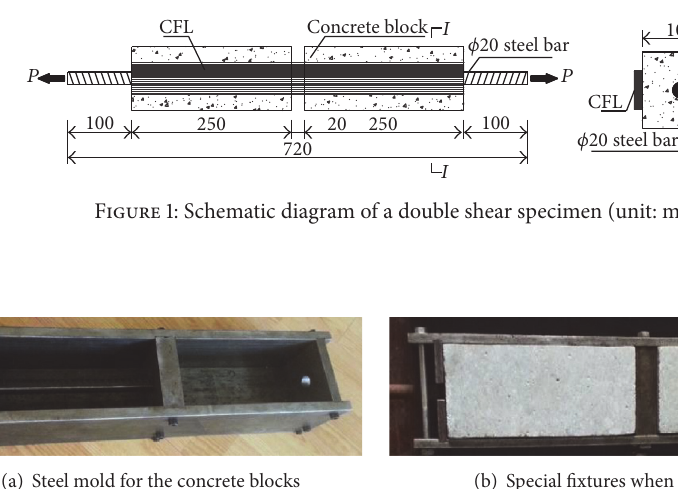
Figure 2: Molds and fixtures used to make the